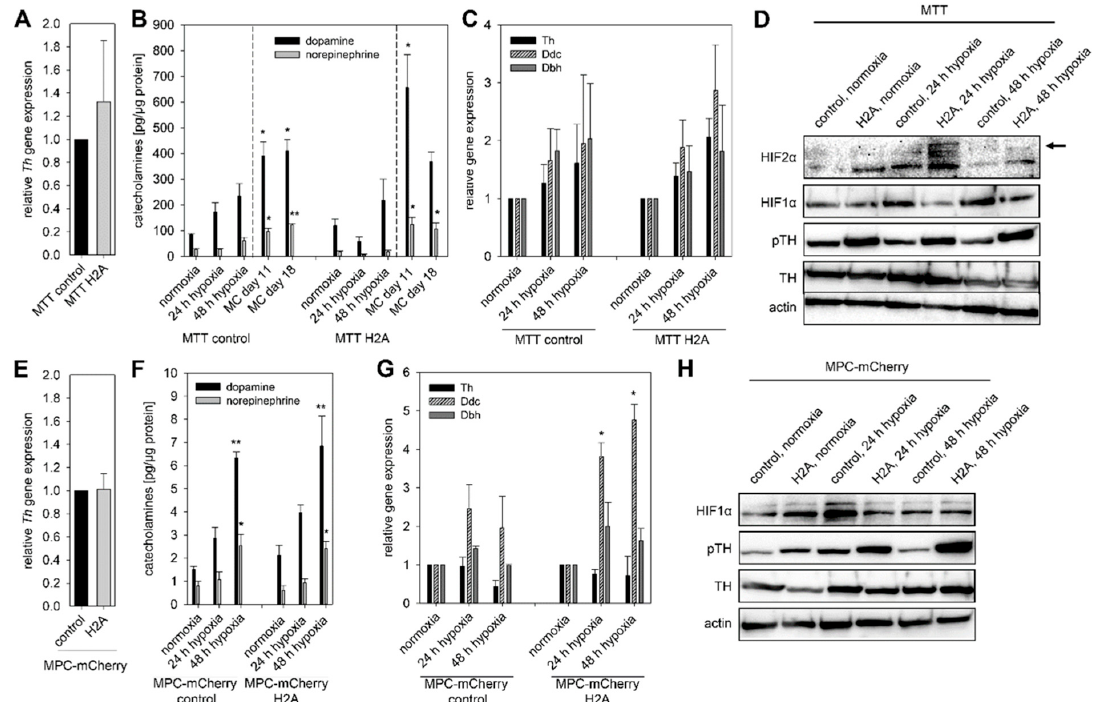
Figure 4. Expression of Hif2 α in mouse pheochromocytoma cells (pseudohypoxic conditions) enhanced the basal phosphorylation of TH, which was further increased by the exposure to hypoxia. ( A ) Expression of Hif2 α in MTT cells had no effect on the relative Th expression determined by qRT-PCR. Three independent experiments ( n = 3). Mean ± SEM. ( B ) In both cell lines with different Hif2 α expression, exposure to extrinsic or intrinsic hypoxia led to elevated DA and NEpi, especially in spheroids generated with the methyl cellulose (MC) method. Three independent experiments ( n = 9). Mean ± SEM. ANOVA and Bonferroni post hoc test comparison vs. normoxia, * p < 0.05, or ** p < 0.01. ( C ) In MTT cells, expression of Th , Ddc and Dbh increased by the exposure to hypoxia independent of their Hif2 α expression. Three independent experiments ( n = 3). Mean ± SEM. ( D ) Pseudohypoxia, simulated by the expression of Hif2 α as well as extrinsic hypoxia led to an enhance phosphorylation of TH at Ser40 in MTT cells. Representative sections of three independent Western blot analysis were shown. To confirm these results MPC-mCherry cells expressing Hif2 α and their counterpart cell line were used. ( E ) Expression of Hif2 α in MPC-mCherry cells had no impact on the relative Th expression. Six independent experiments ( n = 6). Mean ± SEM. ( F ) Similar to MTT cells the exposure to hypoxia resulted in enhanced DA and NEpi in both MPC-mCherry cell lines. Three independent experiments ( n = 9). Mean ± SEM. ANOVA and Bonferroni post hoc test comparison vs. normoxia, * p < 0.05, or ** p < 0.01. ( G ) Expression of Hif2 α was associated with increased expression of Ddc under extrinsic hypoxia. Four independent experiments ( n = 4). Mean ± SEM. ANOVA and Bonferroni post hoc test comparison vs. normoxia, * p < 0.05. ( H ) Western blot analysis confirmed the enhanced phosphorylation of TH at Ser40 under pseudohypoxic conditions in MPC-mCherry cells. Extrinsic hypoxia further increased this effect. Three independent experiments.